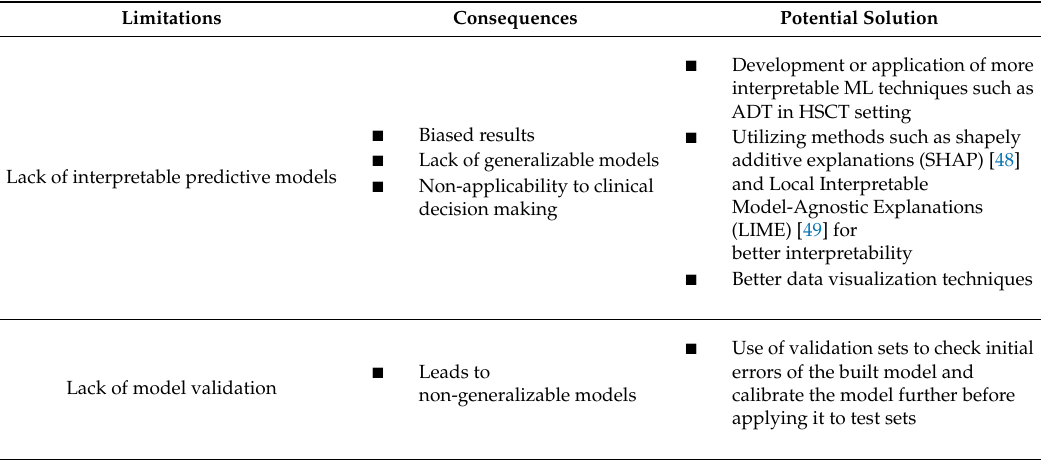
Table 4. Summary of limitations of reviewed